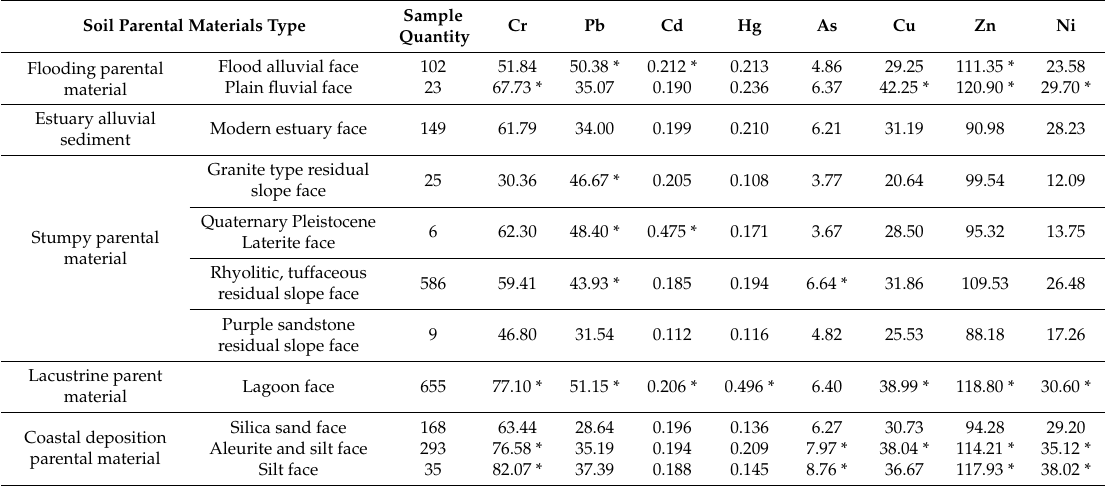
Table 3. Average concentrations of trace elements in soils from different parent materials (mg/kg).